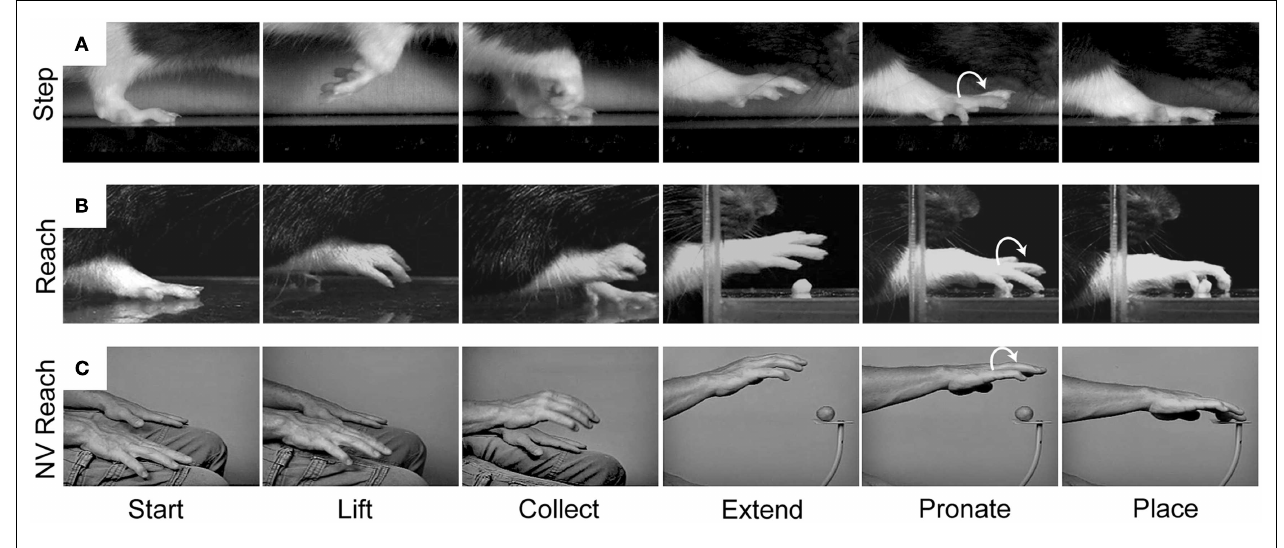
is first lifted from the underlying substrate, the digits collect and extend as the arm is advanced forward, and the hand pronates before being placed on the new substrate. Adapted fromWhishaw et al. (83) and Karl et al.